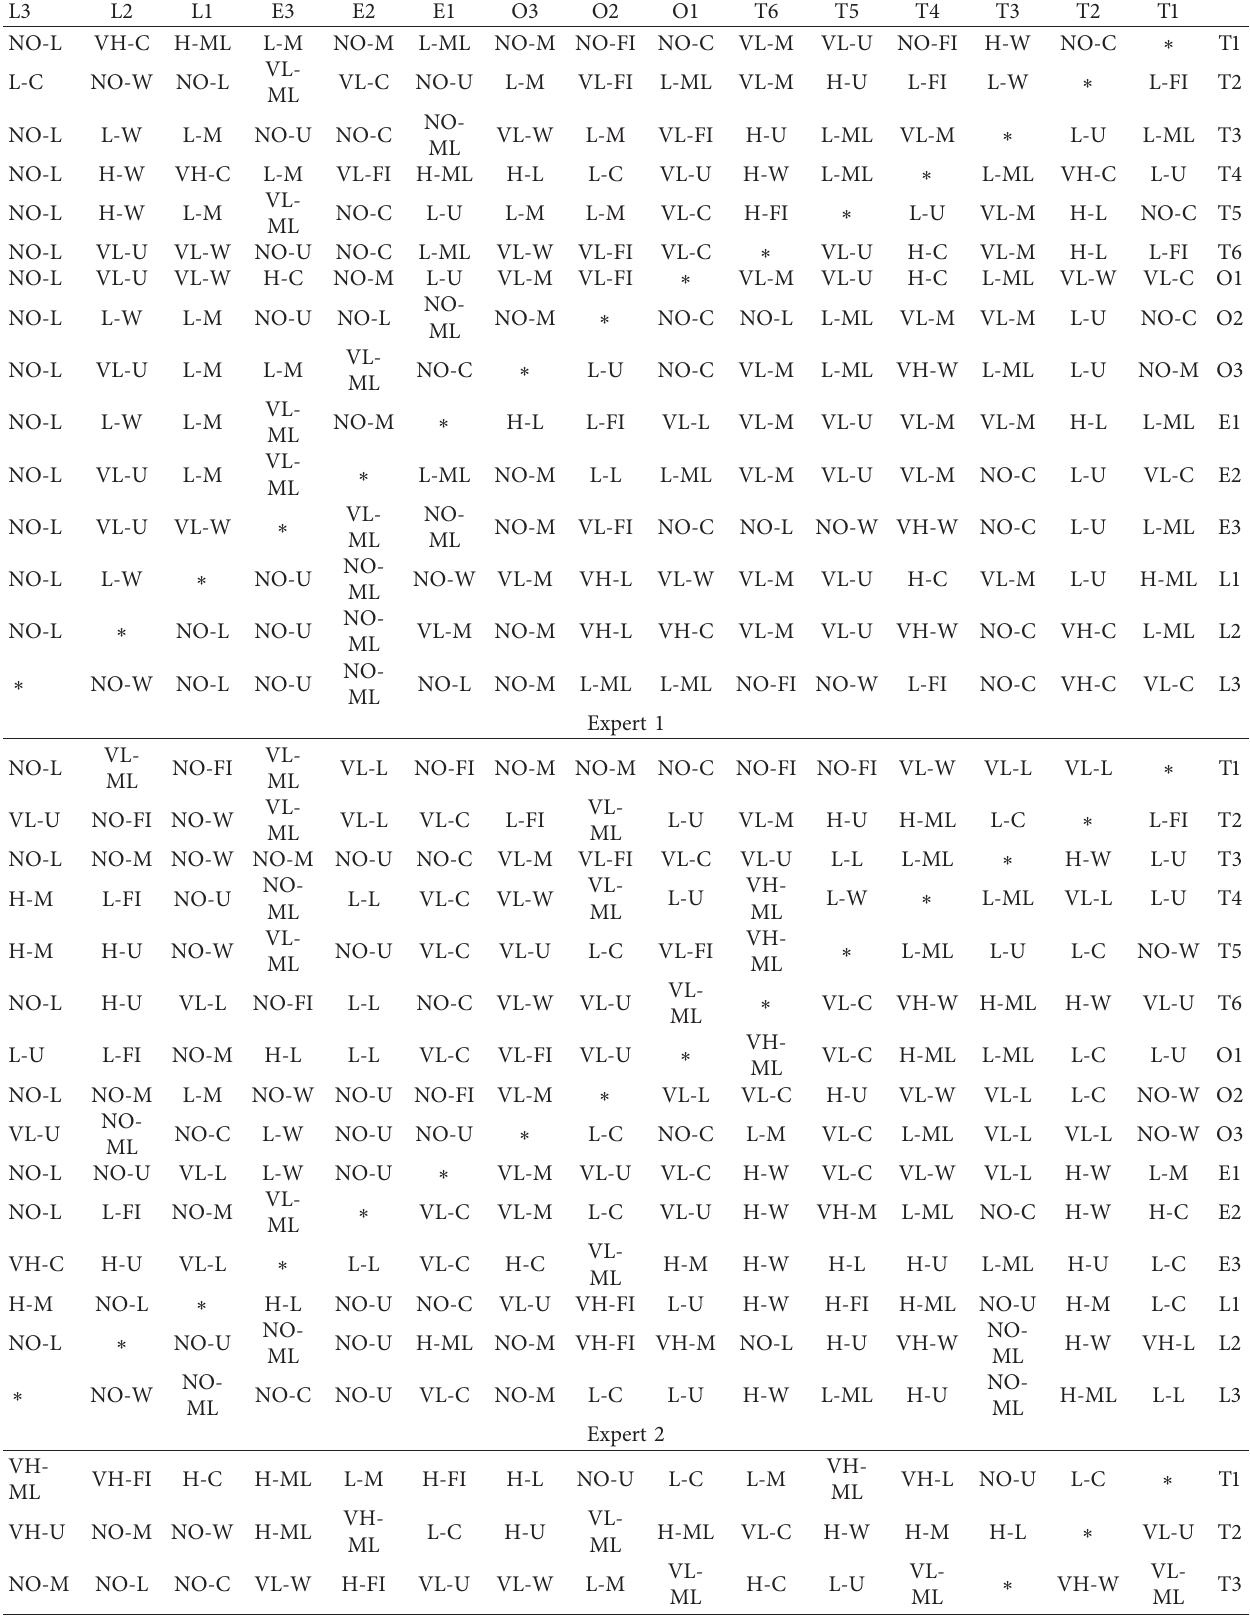
Table 15: Questionnaire